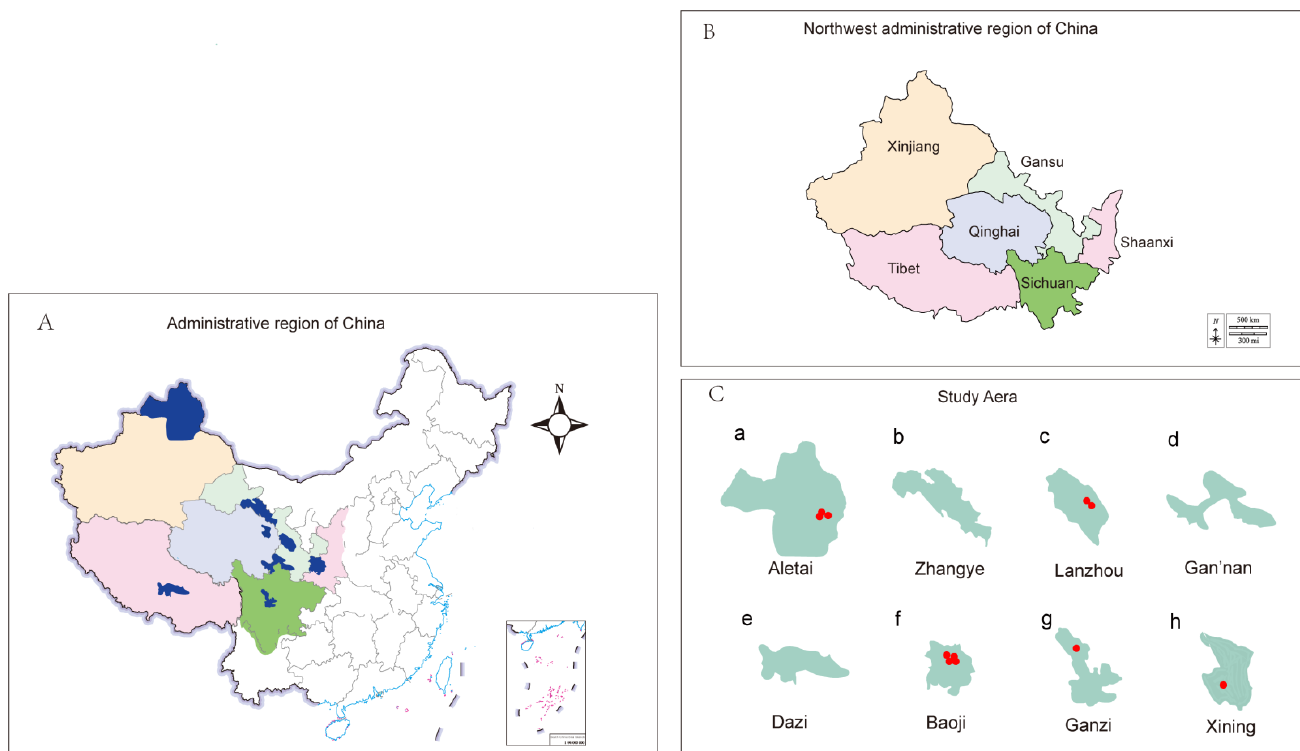
Figure 1. Map of the study plots showing the distribution of tigecycline-resistant isolates. ( A ) Sam- pling areas in the provinces in northwest China. ( B ) The provinces in northwest China are given different colors. ( C ) The study areas, where a red mark indicates a positive result. Table 1. Geographic distribution of the samples collected in this study.